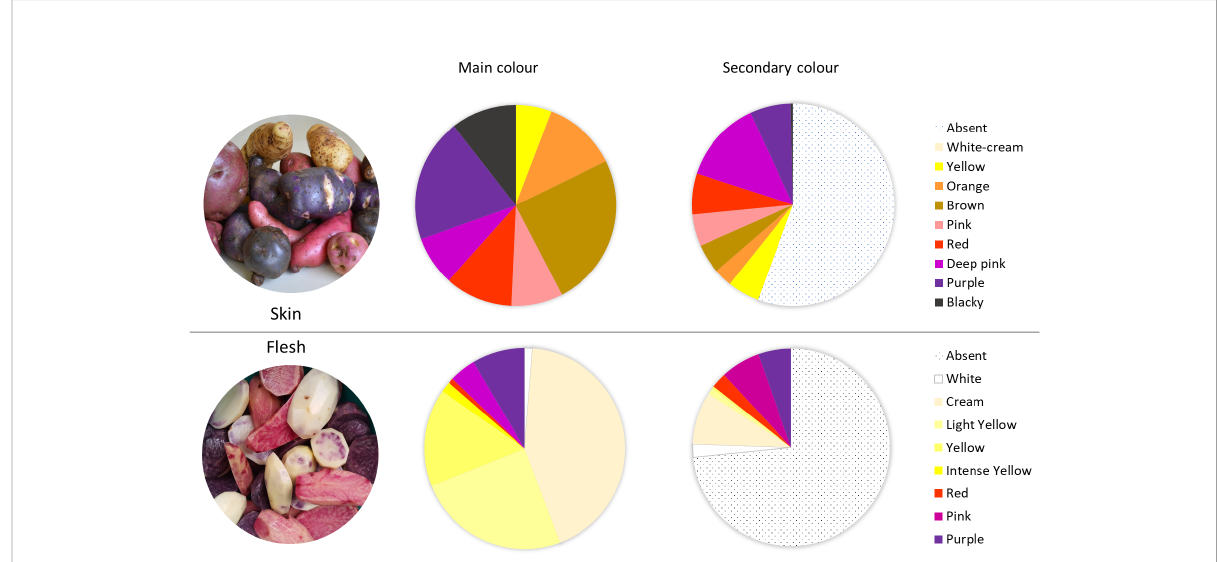
FIGURE 1 Characterization and distribution of accessions in terms of primary (main) or secondary color of the tuber skin (upper panel) and according to primary or secondary fl esh color (lower